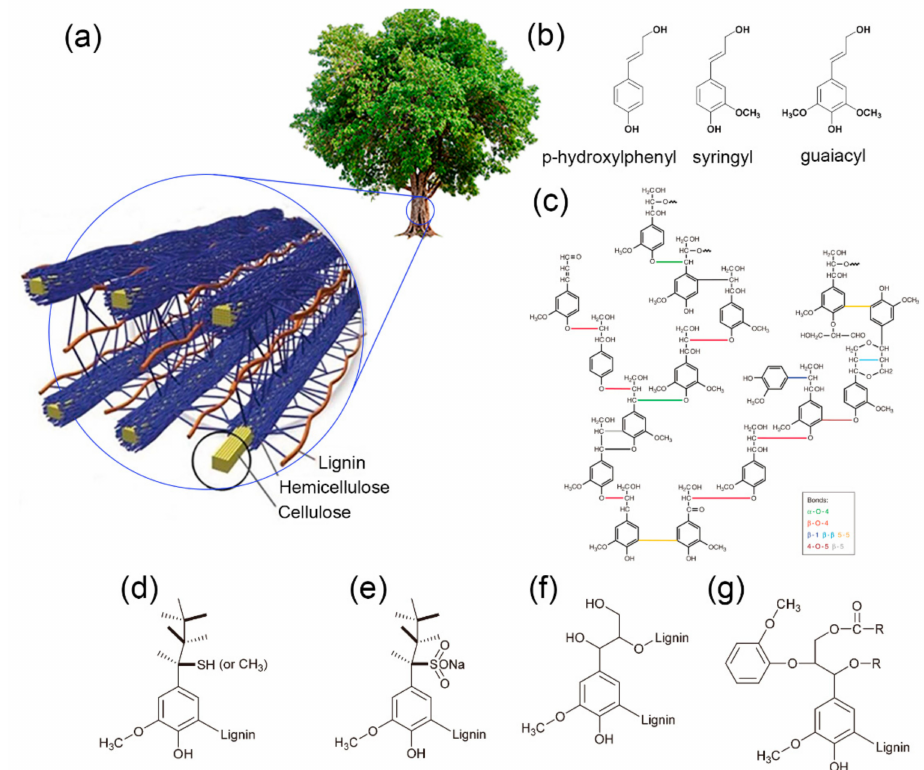
Figure 2. ( a ) The structure of lignocellulose biomass present in plants: highly aligned cellulose strands are surrounded by hemicellulose and lignin. ( b ) The chemical structure of three major monomers of lignin. ( c ) The general chemical structure of lignin with different C–O ( β - O -4, 4- O -5, or α - O -4) and C–C ( β -5, β – β , β -1, or 5-5) linkages. Technical lignins of ( d ) Kraft, ( e ) lignosulfonate, ( f ) soda, and ( g ) organosolv lignin. ( a ) Reproduced with permission from [46], copyright 2011 Elsevier. ( b ) Reproduced with permission from [55], copyright 2015 Royal Society of Chemistry. ( c ) Reproduced with permission from [56], copyright 2012 Elsevier. ( d – g ) Reproduced with permission from [52], copyright 2016 Royal Society of